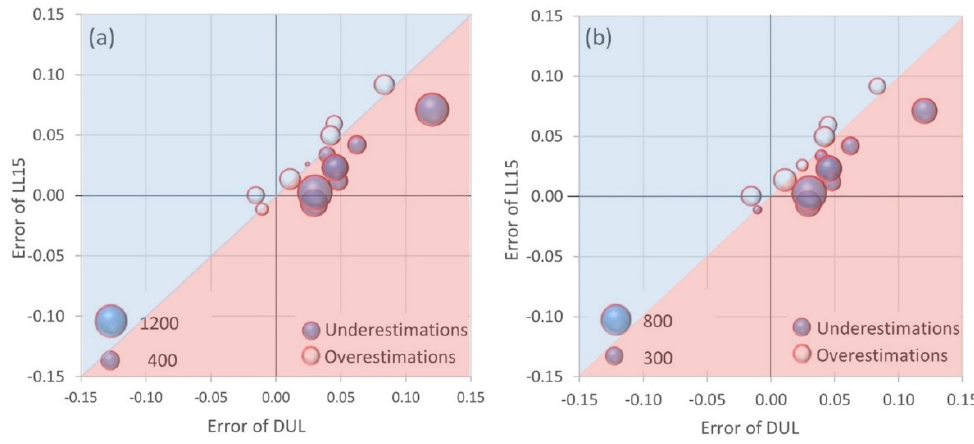
Figure 6. The error variation of PTF-based simulations of average yield (2000–2010) in different locations; ( a ) total above-ground dry matter (kg/ha); WAGT and ( b ) weight of rough rice kg/ha; WRR; LL15: Lower limit (mm/mm), DUL: drainage upper limit (mm/mm); The size of the bubble represents the magnitude of the error of the estimated yield.